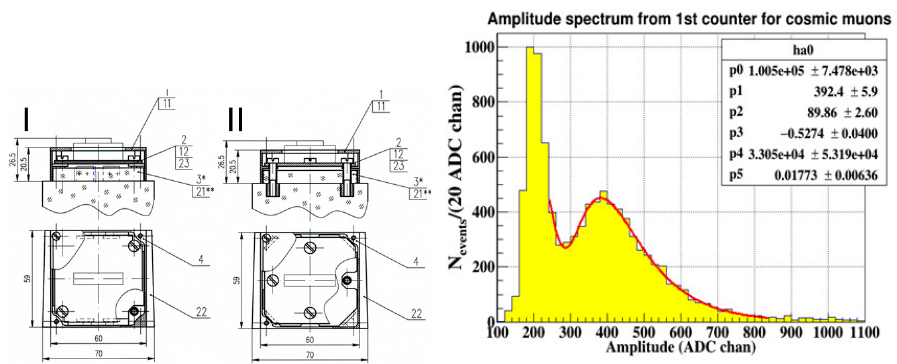
Figure 2. Two variants of the counter: (I) - two pairs of APDs are coupled to the opposite edge sides of the plate of type 1 or 3, (II) - four APDs are coupled to the truncated corners of the plate of type 2 or 4 (left); amplitude spectrum from cosmic particles for the reference counter